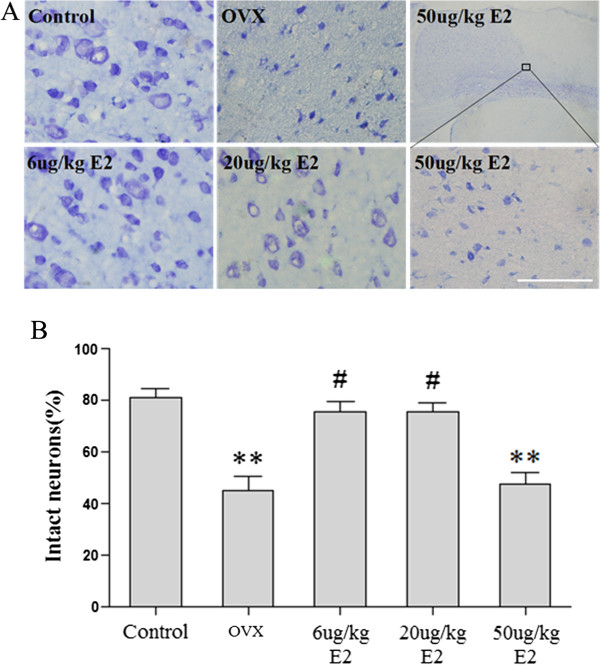
Nissl staining showed the morphologic changes of neurons in the ischemic penumbra after MCAO. (A) Representative photographs showing neuronal damage in the ischemic penumbra after MCAO. (B) The number of injured neurons in the OVX group was significantly more than that in the control group (**p < 0.01). Treatment with 6 μg/kg or 20 μg/kg E2 significantly reduced neuronal damage and preserved morphology (#p < 0.05, v.s. OVX group). However, treatment with 50 μg/kg E2 significantly induced neuronal damage (**p < 0.05 v.s. the control group and 6 μg/kg or 20 μg/kg E2 replacement group). Scale bar: 20 μm.